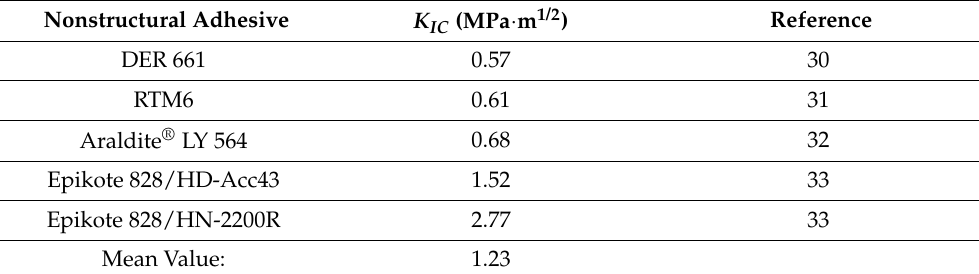
Table 14. Fracture toughness of nonstructural